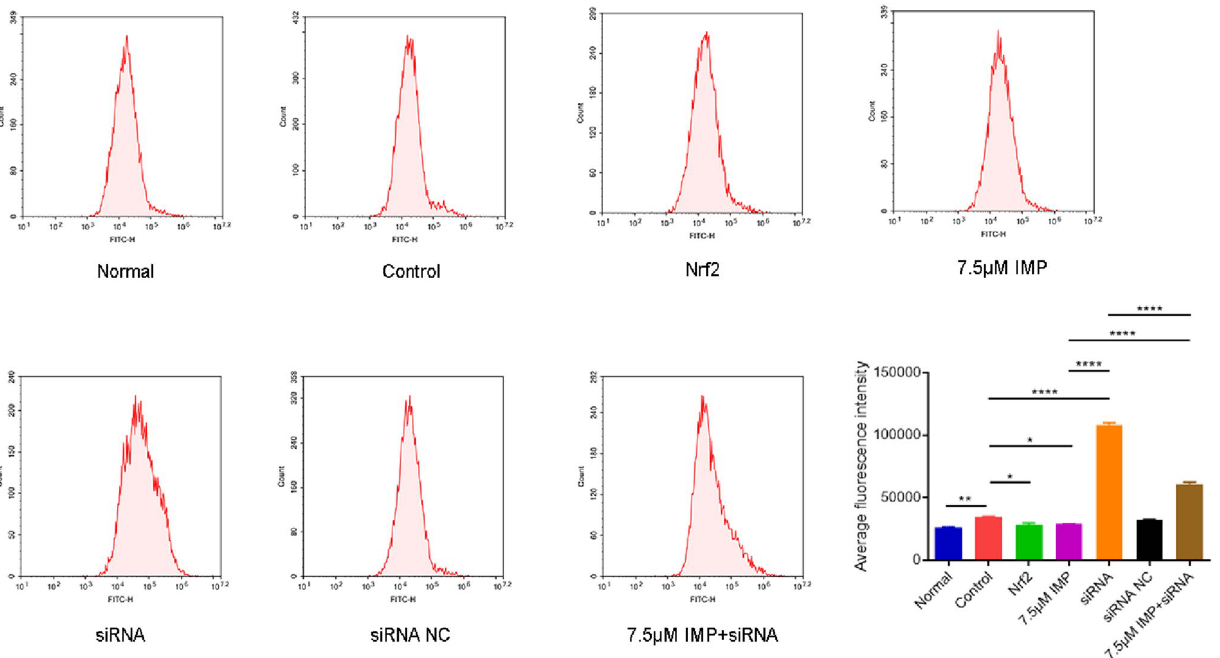
Figure 10. Effects of different treatments on ROS content in VD cell model. The experiment was repeated three times, and the data was shown as mean ± standard deviation. (n = 3 for every group, * P < 0.05, ** P < 0.01, **** P < 0.001 by one-way